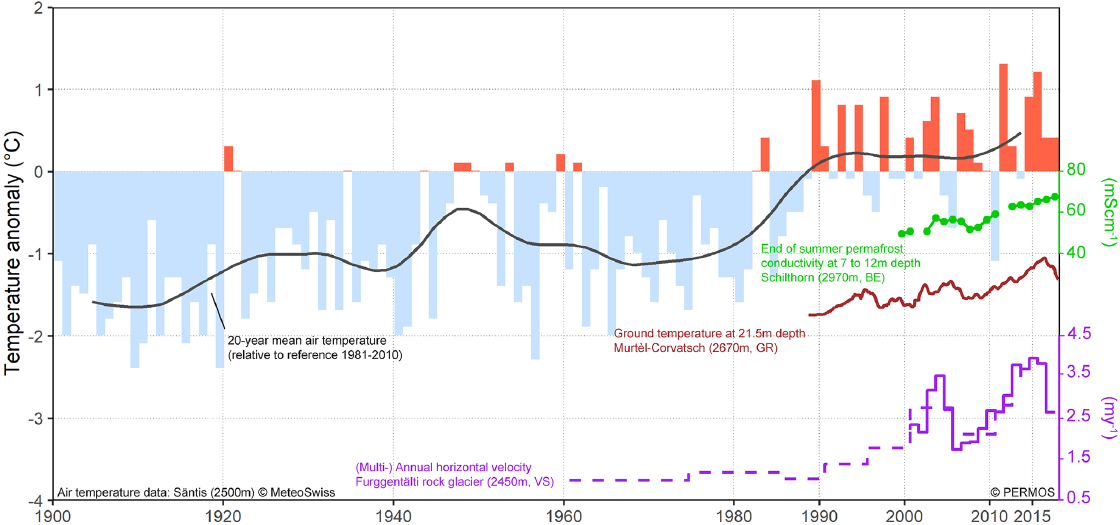
Figure 11. Evolution of the permafrost temperature (brown line), rock glacier horizontal velocity (purple line), and permafrost electrical conductivity (green dots and line) at selected PERMOS field sites in the context of long-term climate observations. Annual air temperature anomaly (relative to the 1981–2010 norm period) measured at Säntis (2500m) is shown by blue and red bars, and its smoothed value is shown in black. The dashed purple line represents horizontal rock glacier velocity reconstructed from orthophotos (PERMOS,